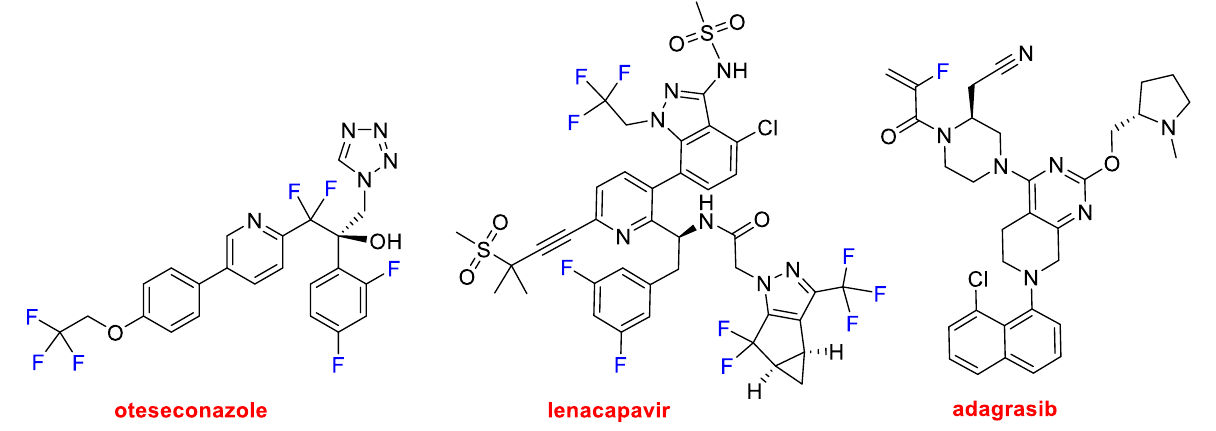
Figure 11. Structures of the F containing drugs: oteseconazole, lenacapavir, and adagrasib.